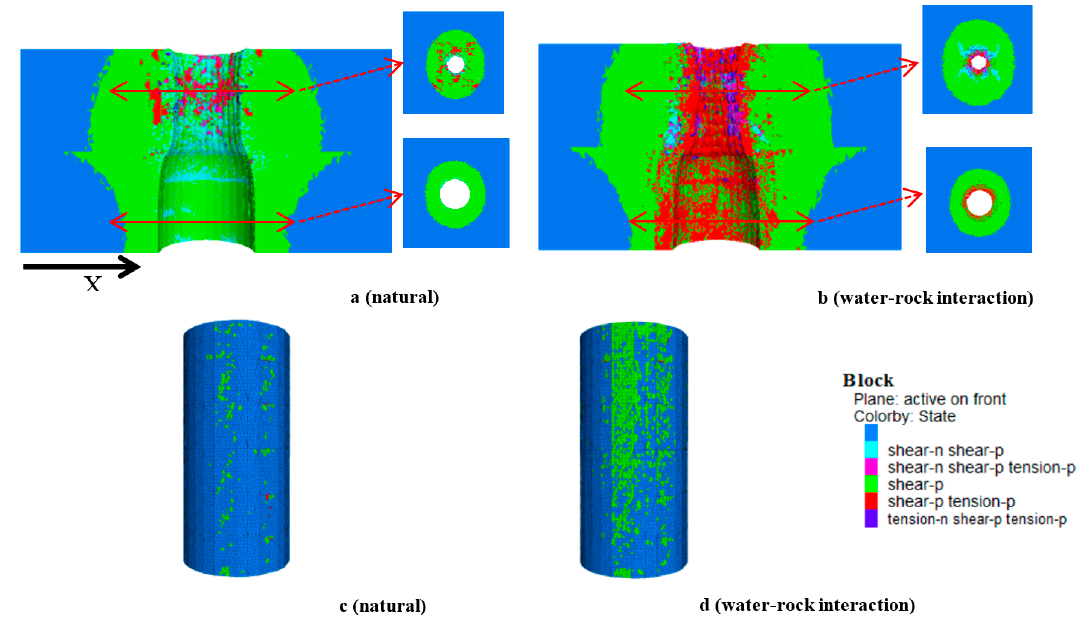
Figure 13. Distribution of plastic zone.